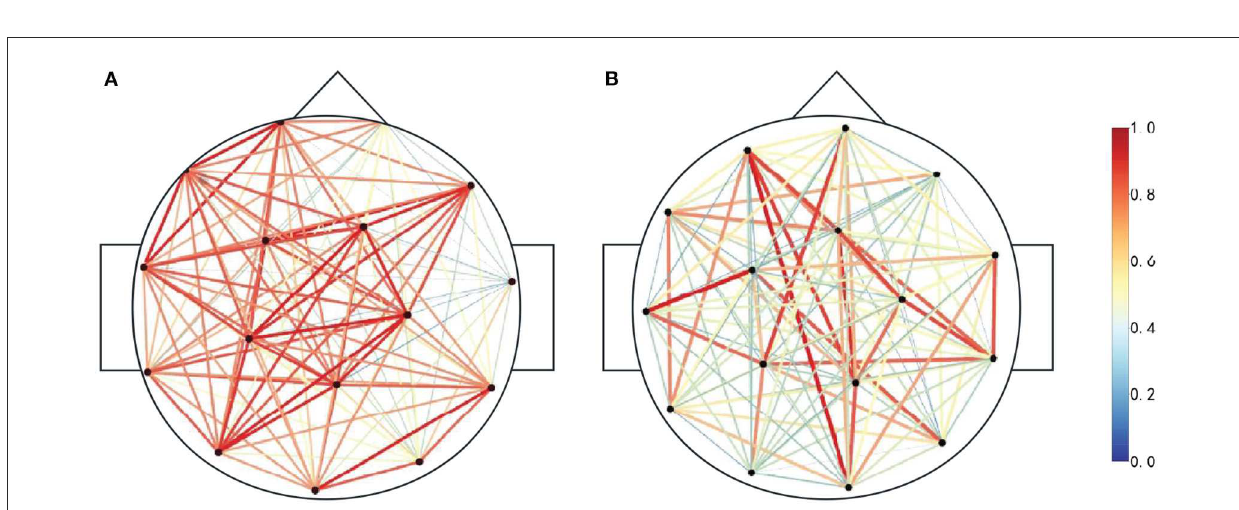
FIGURE5 Functional brain network connections. The darker the color represents the weight of each side, the more red connections indicate the stronger signal phase synchronization between the two nodes, and the more bluer connections indicate the weaker signal phase synchronization between the two nodes. (A) Spike discharge. (B) Nospike